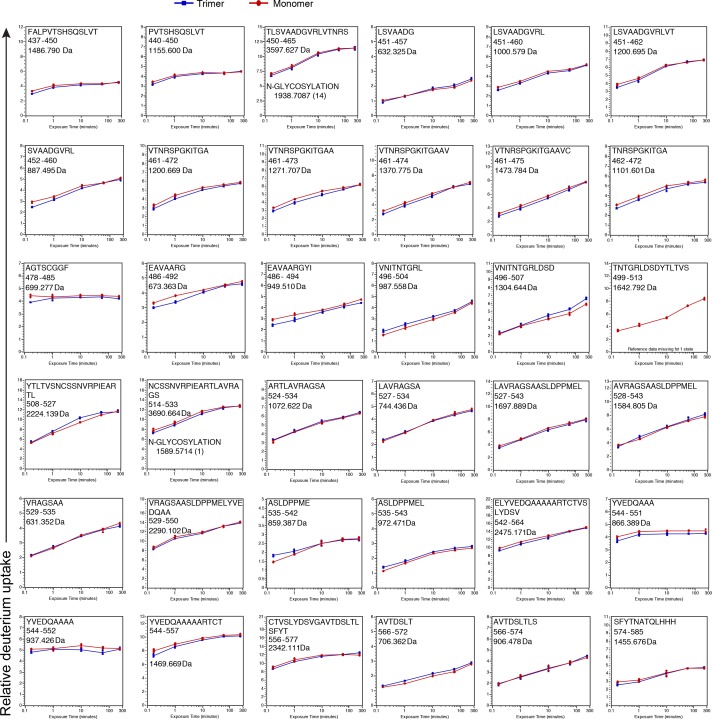
See legend for Figure 2—figure supplement 3 .